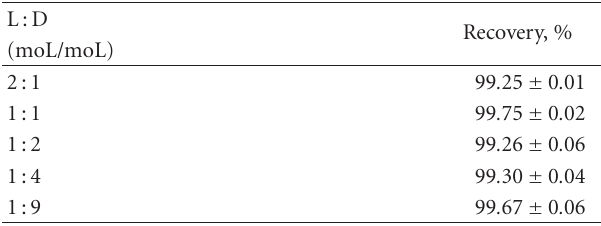
Table 3: The results obtained for the determination of L-glyceric acid in the presence of D-glyceric acid a .